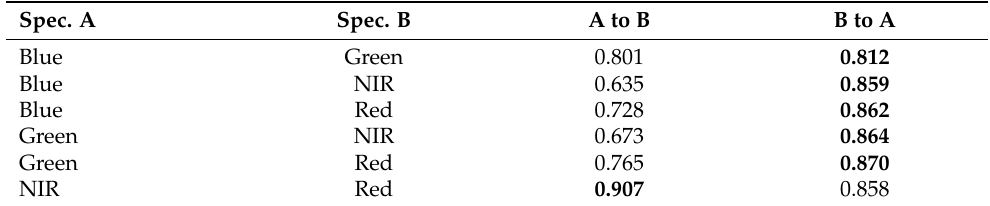
Table 2. SSIM results in the evaluation of spectrum pairs using StarGAN. The higher one is shown in